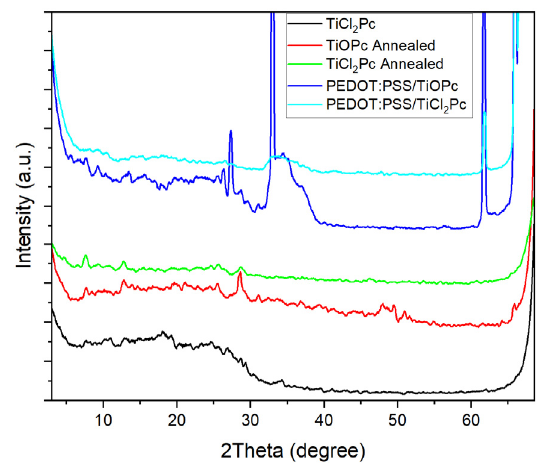
Figure 5. XRD patterns of the TiOPc and TiCl 2 Pc films and devices. Table 3. XRD peak position, FWHM, and crystallite size for the TiOPc and TiCl 2 Pc films and de- vices.